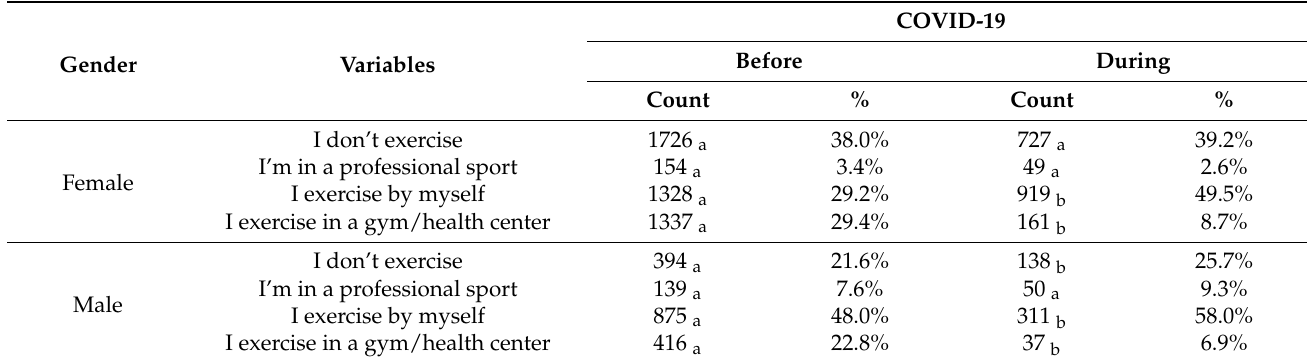
Table 1. Choice of the forms of PA for men and women before and during COVID-19.